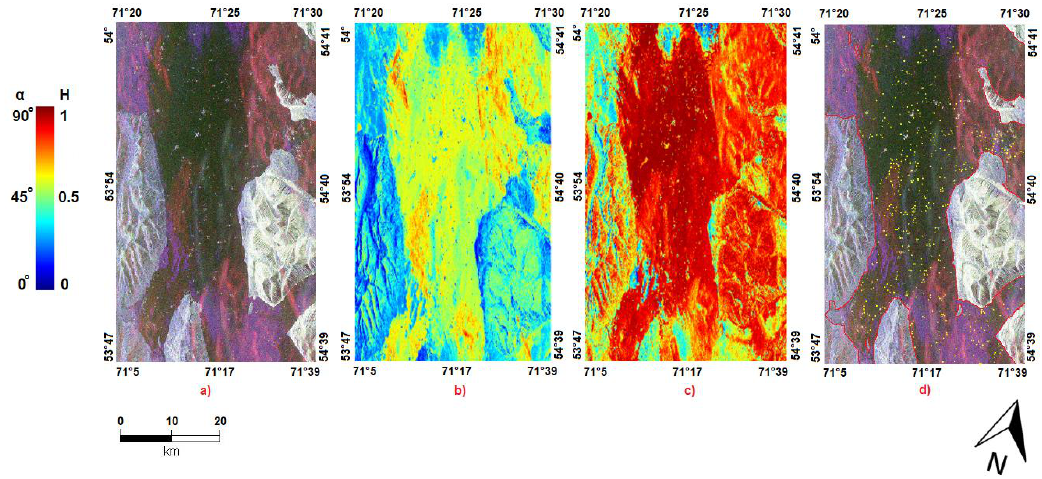
Figure 5. Output images for Nuugaatsiaq, 05 / 08 / 2015 02:48, ( a ) Pauli RGB, ( b ) alpha image in a 5 × 5 window, ( c ) entropy image in a 5 × 5 window, ( d ) Pauli RGB visual analysis of icebergs. Yellow dots show icebergs. Red outline indicates coastline. Numbers on the edges of images indicate image DMS coordinates. The sea ice situation is mostly open ocean.